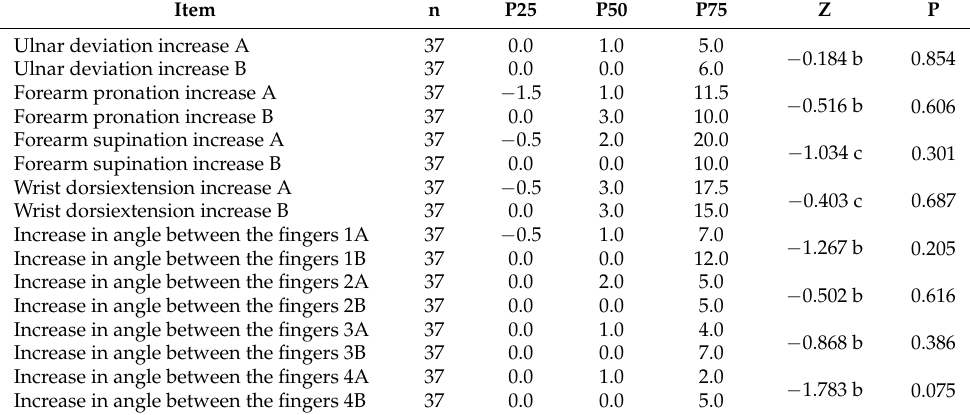
Table 2. Comparison of the MDIVQAS and protractor before and after